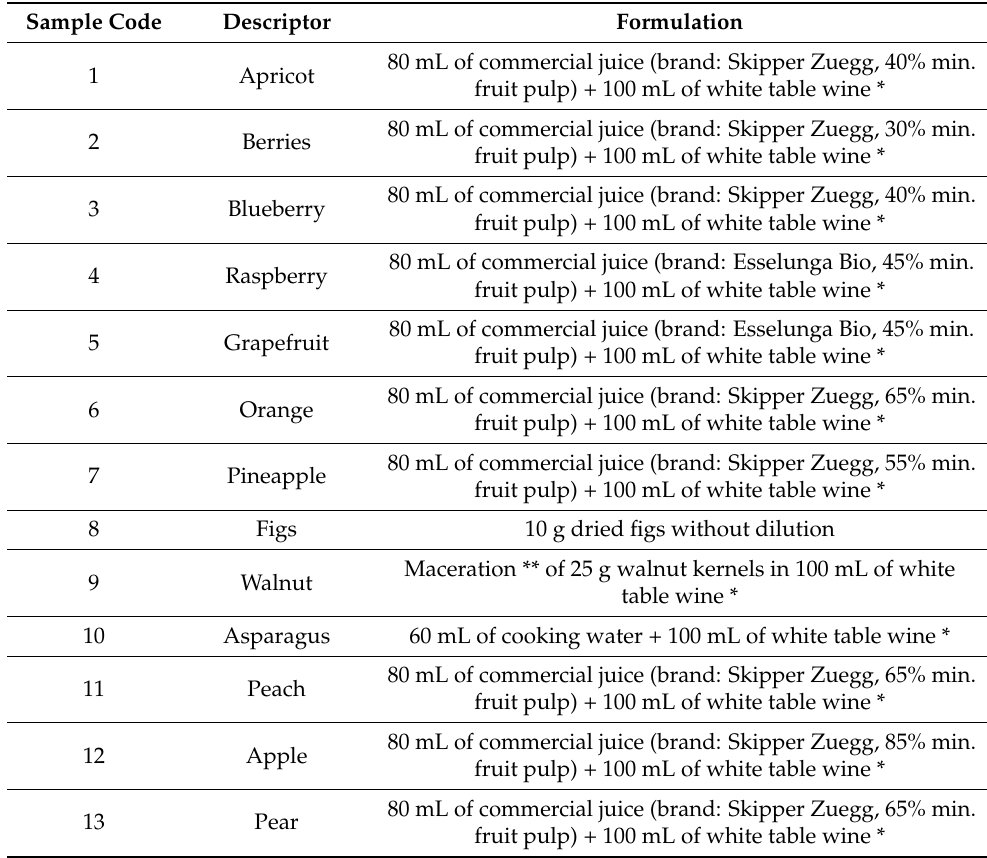
Table 1. Odorous solutions used for the stimulation.